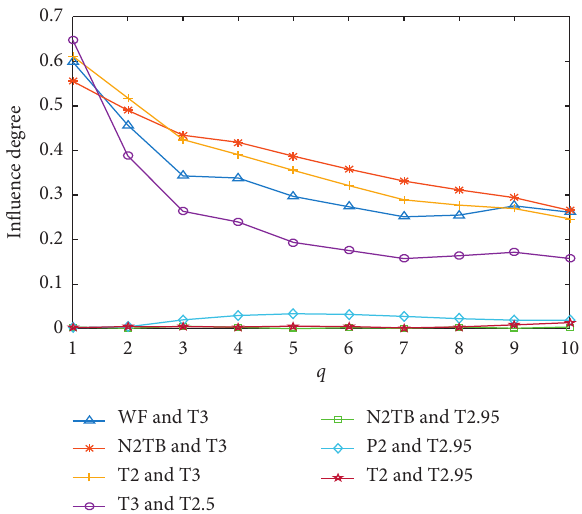
Figure 12: The influence degree of the 2-controlling-variables detrended partial cross-correlation for aeroengine